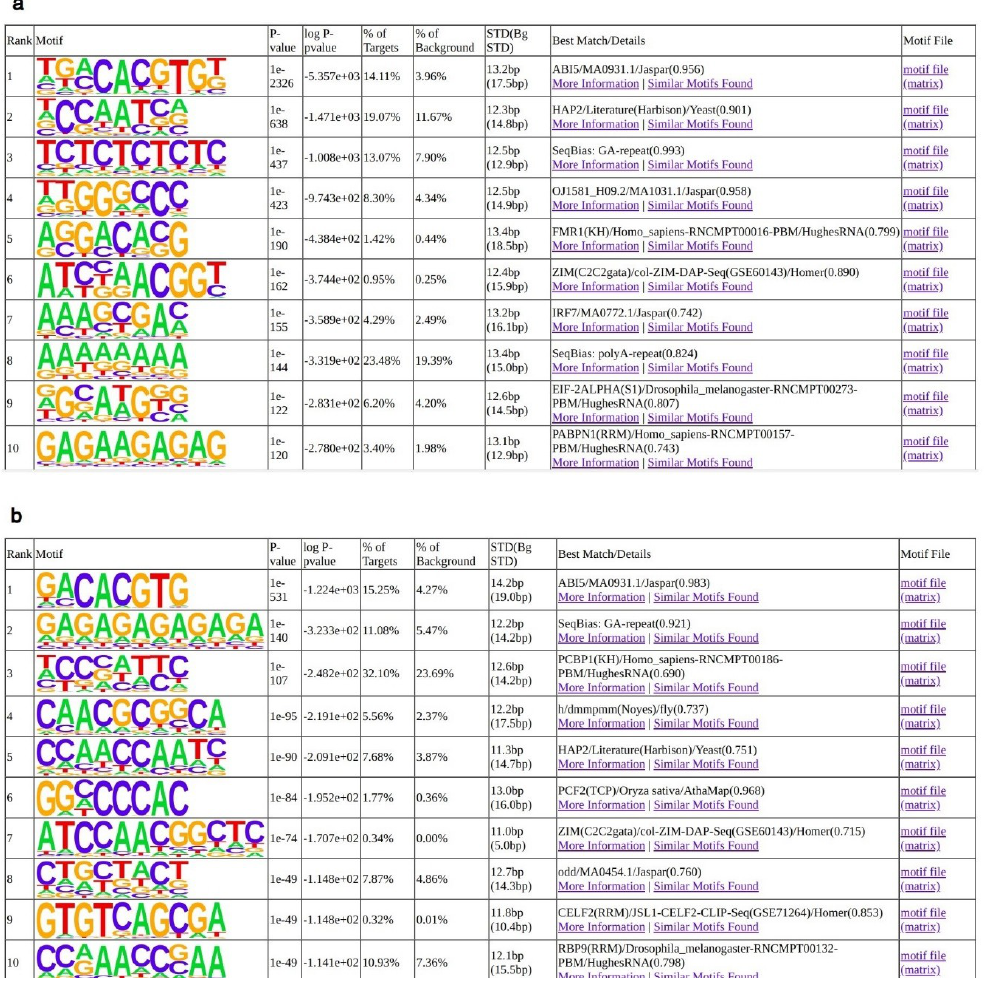
Figure 4. Analysis of LEC1 binding sites in vivo . Enriched motifs, as recovered by Homer ( p -value ≤ 10e−30) for soybean LEC1 peaks [33]. ( a ) All Peaks. ( b ) Peaks in promoter regions (defined as genomic intervals from −500 bp to an annotated TSS).